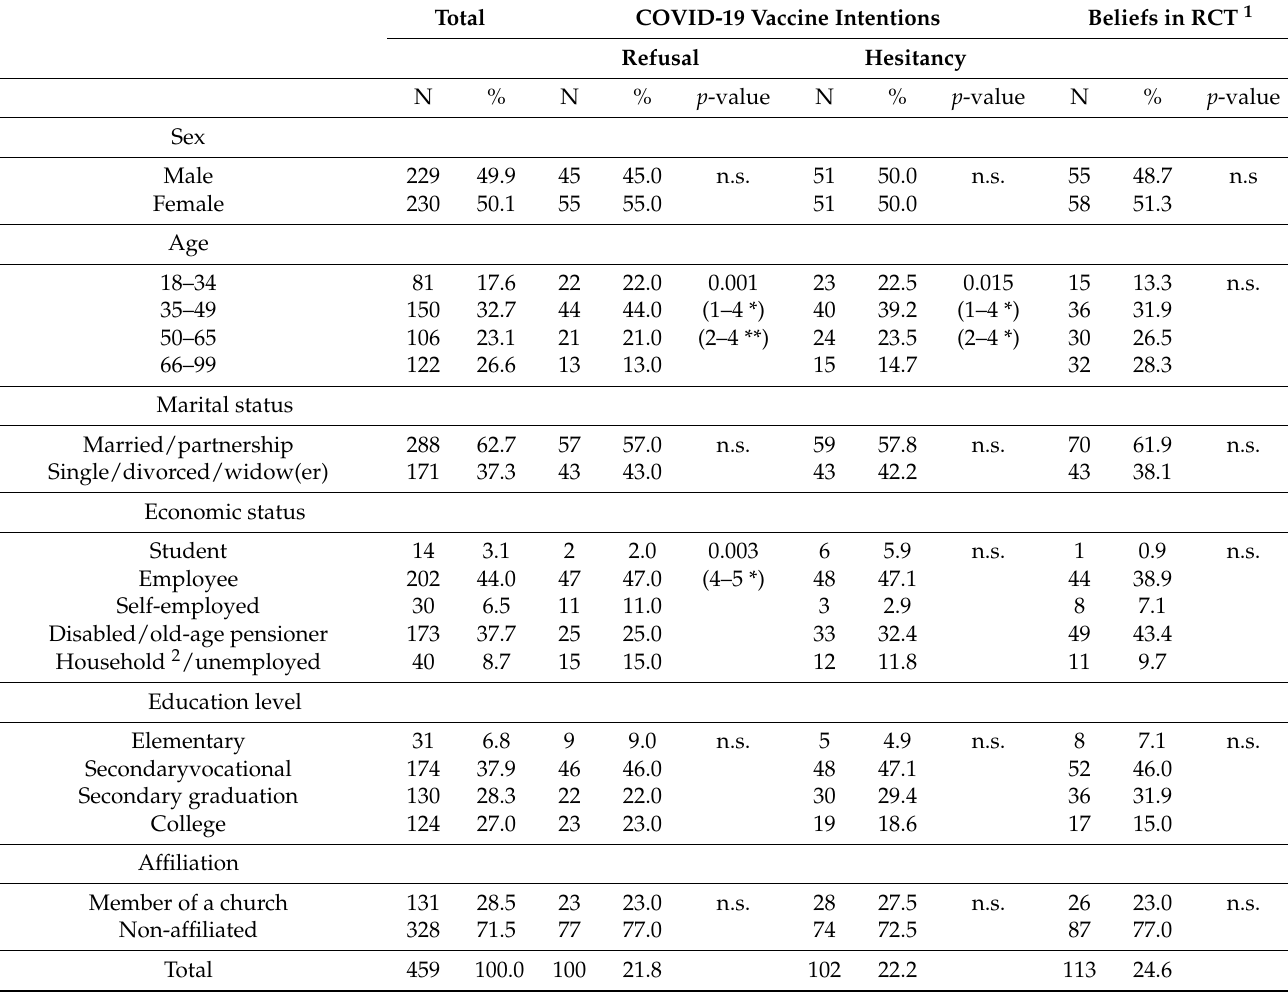
Table 1. Description of the study